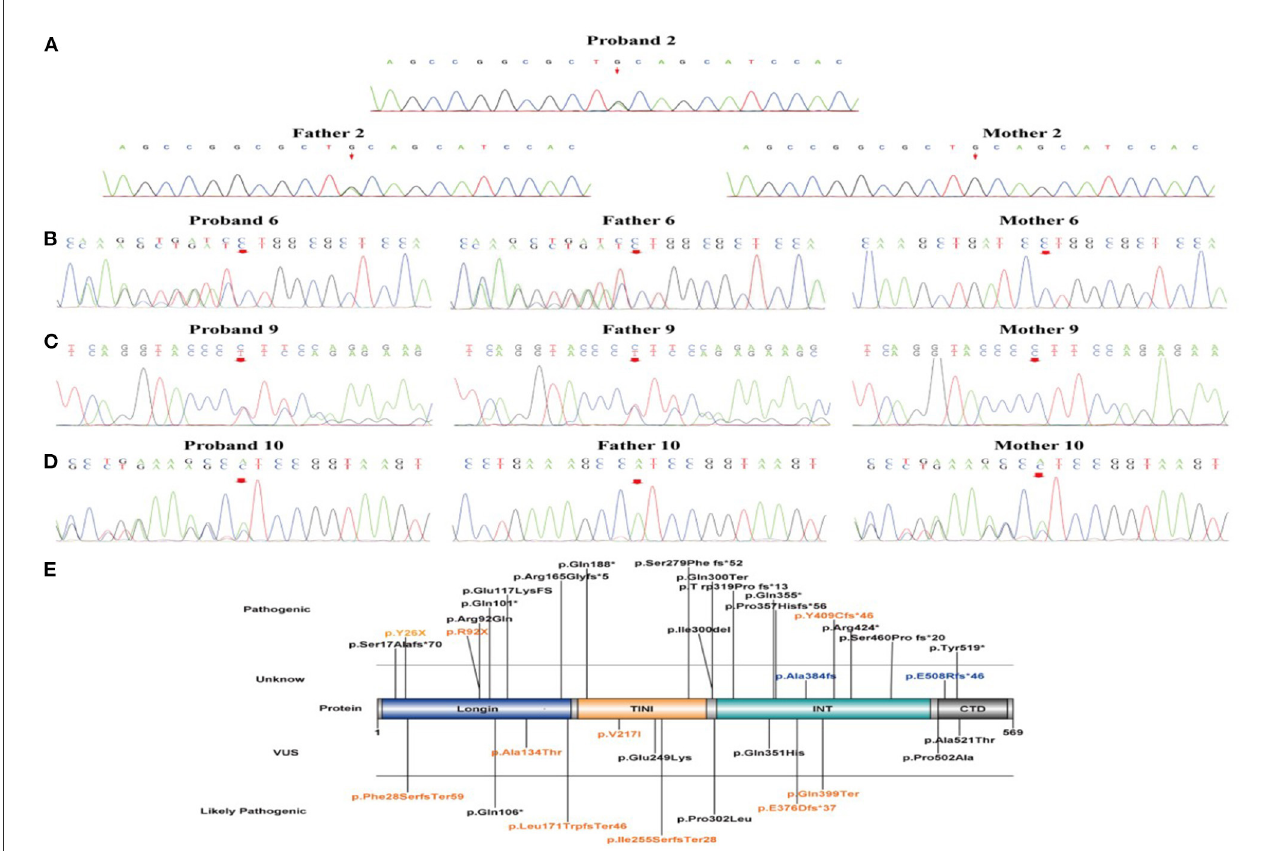
FIGURE2 The validation of NPRL3 variants by Sanger sequencing and schematic diagram of NPRL3 protein. (A–D) Sanger sequencing results of the proband 2, 6, 9, and 10 and their parents, respectively. (E) Schematic diagram of the variant sites in NPRL3 proteins from our results and previous literature identified. The pathogenic variants identified in this study are illustrated and highlighted in yellow.